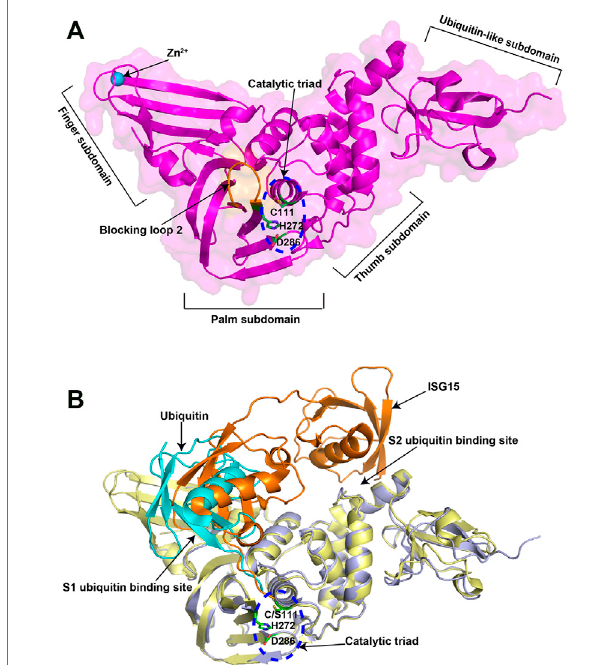
FIGURE 2 | Crystal structures of SARS-CoV-2 PLpro in apo and substrate-bound forms. (A) Crystal structure of SARS-CoV-2 PLpro (PDB ID: 6WZU). The four distinct subdomains are indicated. The catalytic triad is shown in the blue dashed circle. (B) Superposition of ubiquitin/PLpro complex (PDB ID: 6XAA) with mouse-ISG15/PLpro complex (PDB ID: 6YVA). Thecatalytictriadisshowninthebluedashedcircle.Thetwoubiquitinbinding sites are indicated. The ubiquitin is colored in cyan, while the mouse ISG15 is colored in